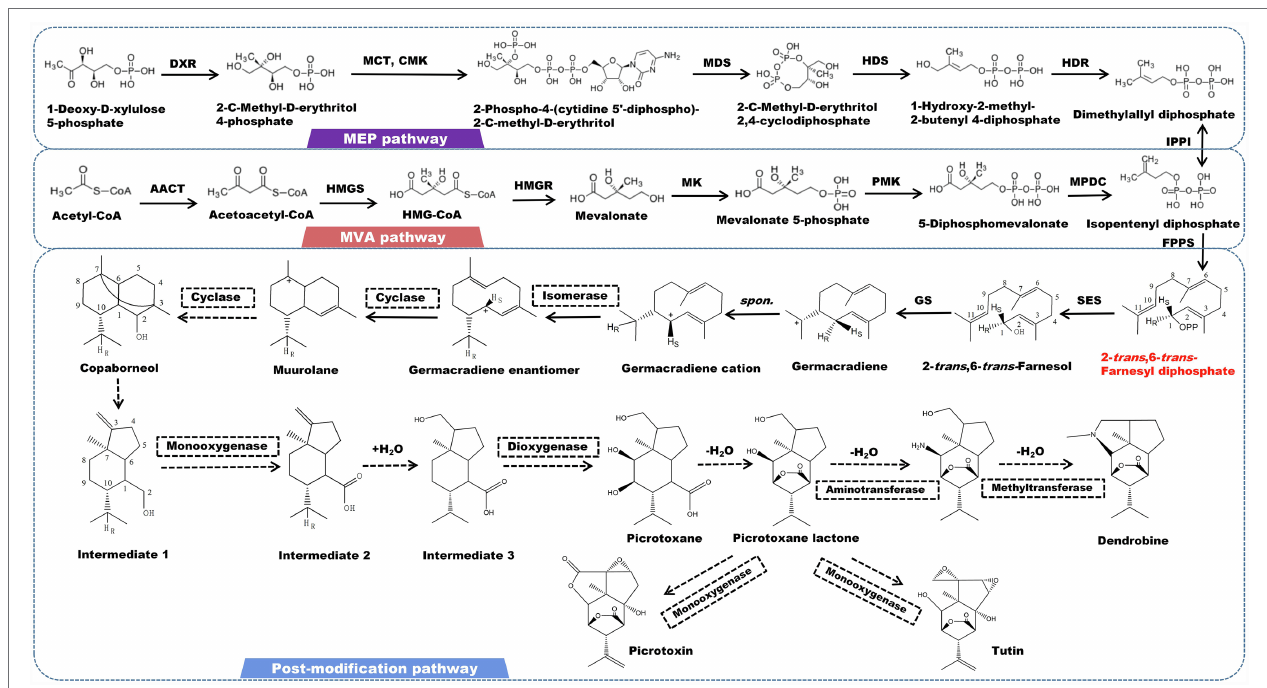
FIGURE 2 | A plausible biosynthesis pathway of sesquiterpene alkaloids. The dashed box represents the putative enzymes. The dashed arrow represents the speculated pathway. Acetyl-CoA acetyltransferase (AACT), HMG-CoA synthase (HMGS), HMG-CoA reductase (HMGR), mevalonate kinase (MK), phosphomevalonate kinase (PMK), mevalonate diphosphate decarboxylase (MPDC), 1-deoxy-D-xylulose 5-phosphate reductoisomerase (DXR), 2-C-methyl-D- erythritol 4-phosphate cytidylyltransferase (MCT), 4-diphosphocytidyl-2-C-methyl-D-erythritol kinase (CMK), 2-C-methyl-D-erythritol 2,4-cyclodiphosphate synthase (MDS), 4-hydroxy-3-methylbut-2-enyl diphosphate synthase (HDS), 4-hydroxy-3-methylbut-2-enyl diphosphate reductase (HDR), isopentenyl pyrophosphate: dimethylallyl pyrophosphate isomerase (IPPI), farnesyl diphosphate synthase (FPPS), sesquiterpene synthase (SES), germacradiene synthase (GS). SES catalyzes the formation of the precursor 2- trans -6- trans -farnesol by 2- trans -6- trans -farnesyl